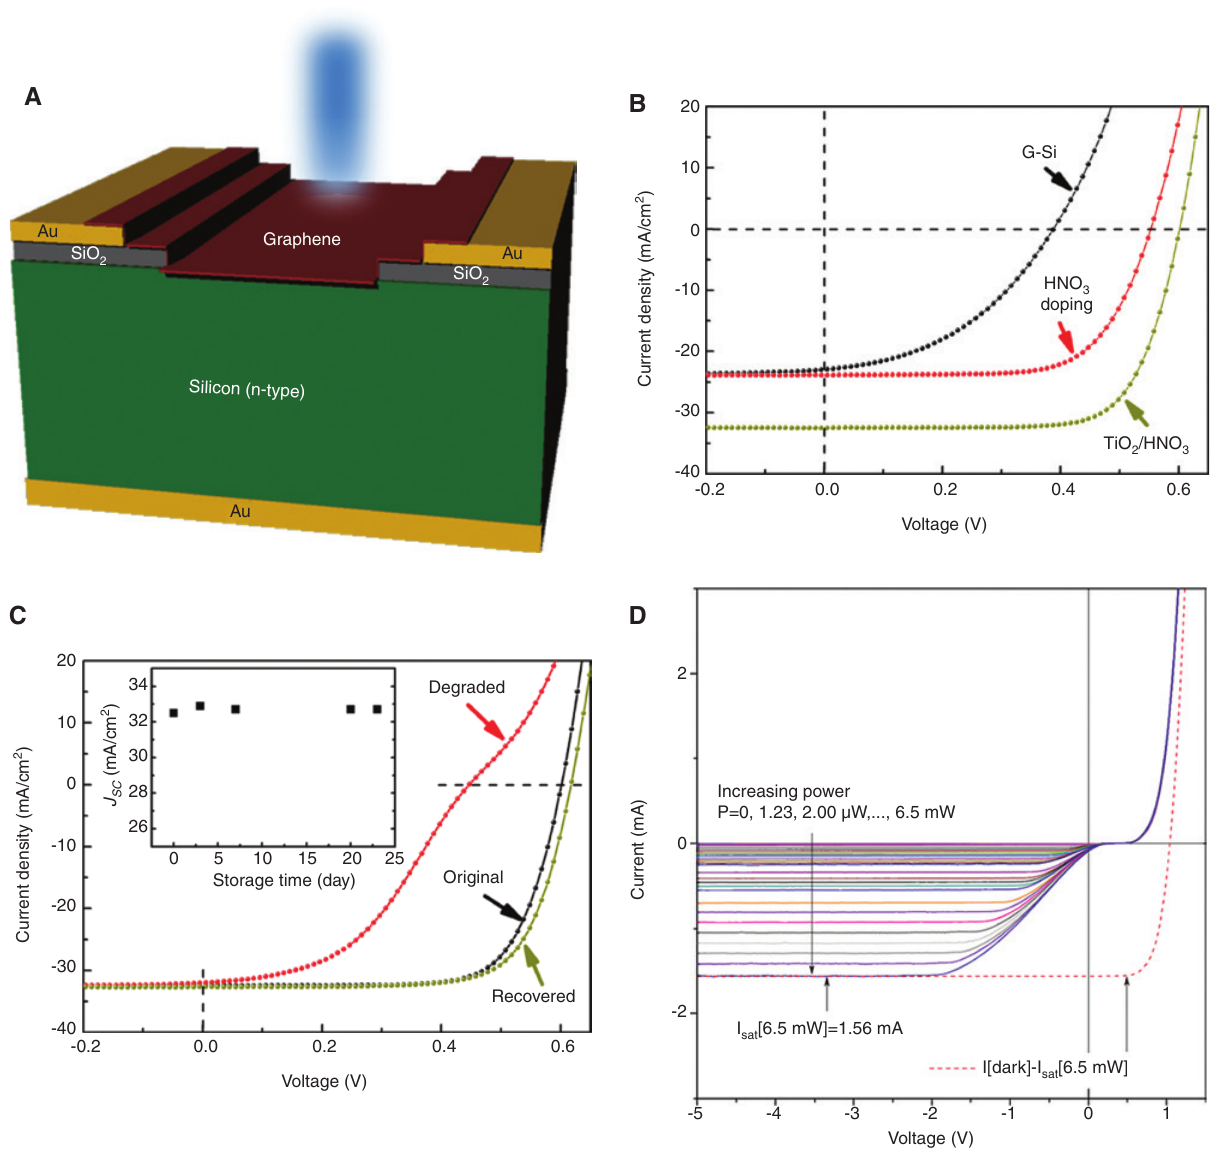
Figure 5: (A) Schematic diagram of the graphene/silicon device. (B) Measured I-V curves of the graphene/silicon device when used as a solar cell. The black curve is the solar I-V of bare graphene on silicon. The red curve is after doping the graphene with HNO , and the yellow curve is 3 the solar I-V after spin coating with TiO [40]. (C) Solar I-V curves of the device in (B) showing the degradation of the cell performance after a 2 long period of time. The recovered curve is measured after doping the cell with HNO . The inset shows the short-circuit current as a function of 3 time. (D) Measured I-V curves of the graphene/silicon device at several incident laser powers when used as a photodetector